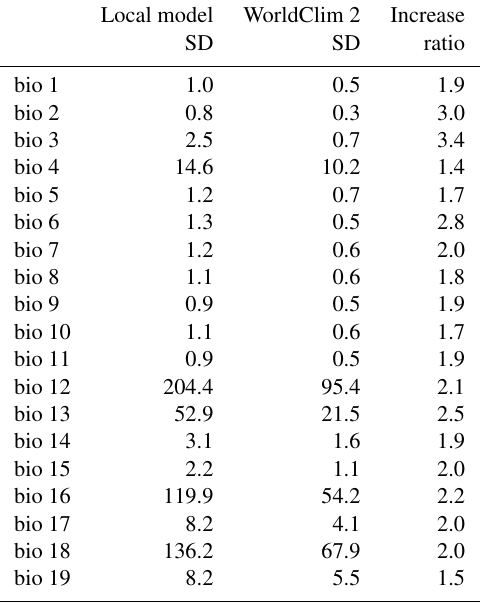
Table 3. Comparisons of variation between bioclimatic variables, measured as raster value standard deviation. All new rasters are more variable than their corresponding WorldClim 2 layers. In- creases in standard deviation range from 1.4x to 3.4x. Calculations may appear inaccurate due to